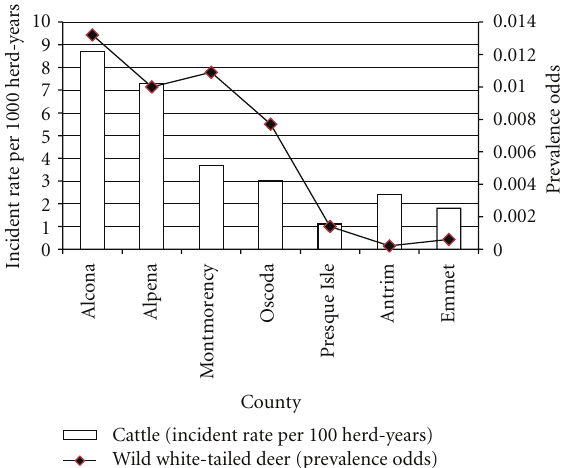
Figure 5: Prevalence odds and incident rate of BTB in Michigan wild white-tailed deer and cattle herds, respectively, 1975–July 2010.